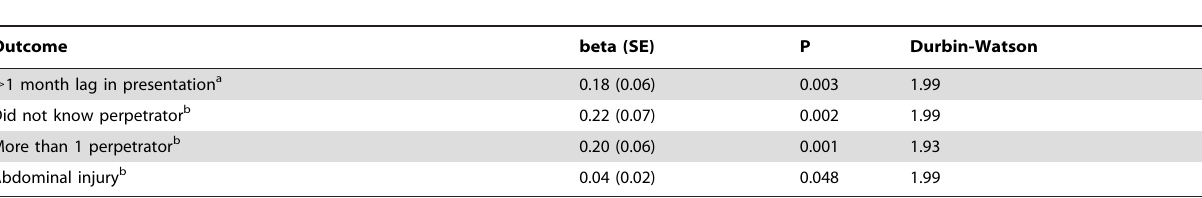
Table 2. Prais-Winsten models for key